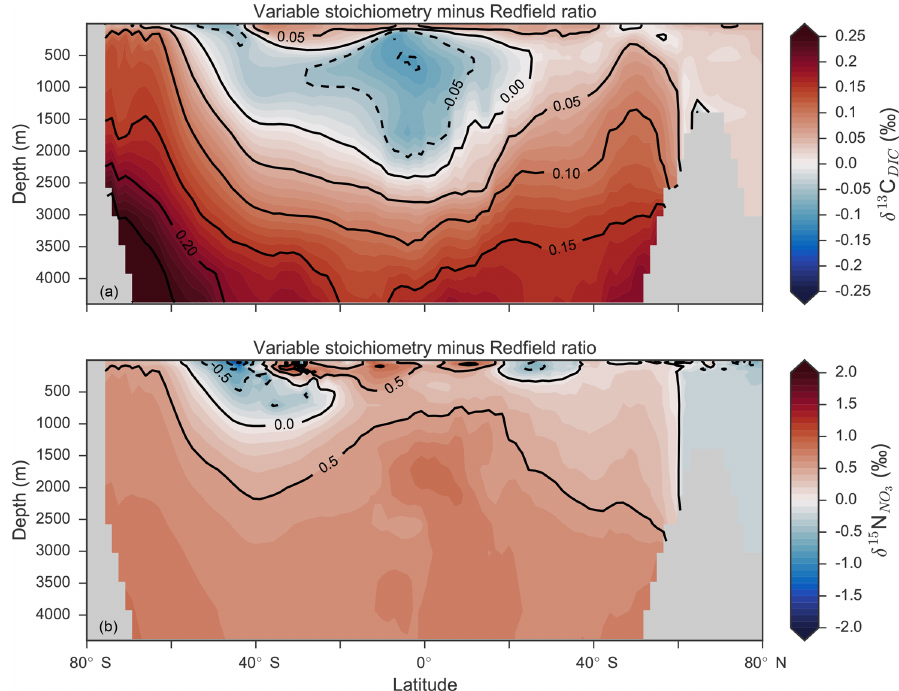
Figure 12. Differences in δ 13 C DIC (a) and δ 15 N NO are zonal